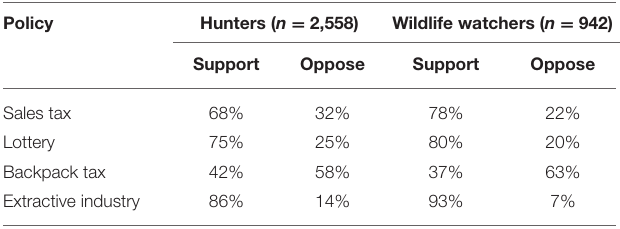
TABLE 1 | Support and opposition for conservation policies by stakeholder group (%).